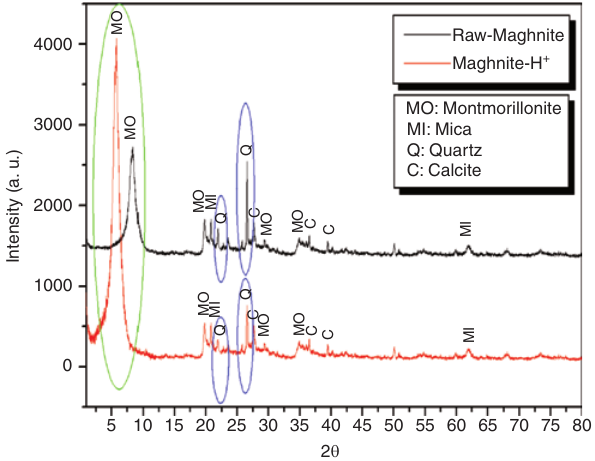
Figure 2: Infrared (IR) spectra of polyphenylmethylsiloxane (PPMS) obtained by the polymerization of tetraphenyltetramethylcyclotetra- siloxane (D 4Ph,Me ) at a temperature of 60 ° C for different